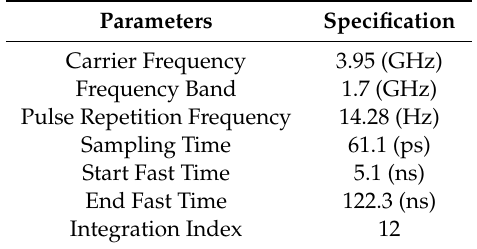
Table 1. Operative Radar System Parameters: First Test